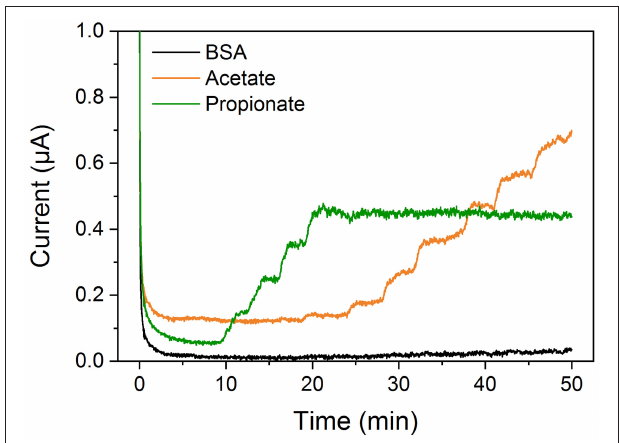
FIGURE 4 | Chronoamperometric measurement with the VFA biosensor in 100 mM potassium phosphate buffer (pH 7.0) with 5 mM MgCl 2 , 0.6 mM TPP, 0.02 mM FAD, 2 mM PEP, 1 mM ATP and 0.4 mM acetyl-CoA, 11.8 U PK and 2.5 U AK. Cross-talk free behavior is demonstrated by subsequent addition of propionate and acetate, respectively.